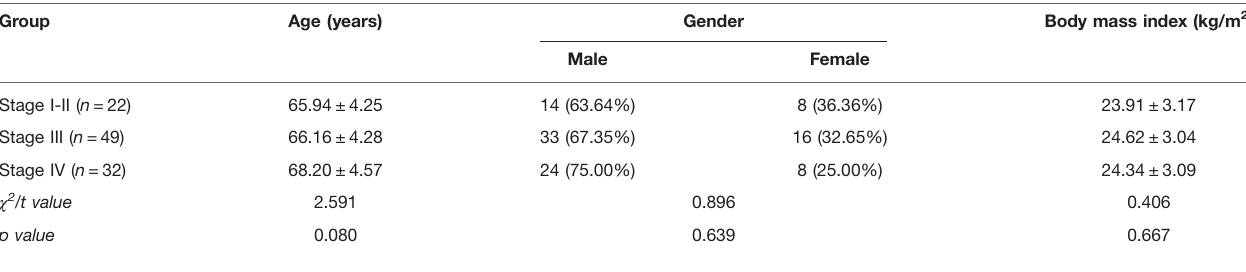
TABLE 1 | Basic information of CRC patients in different